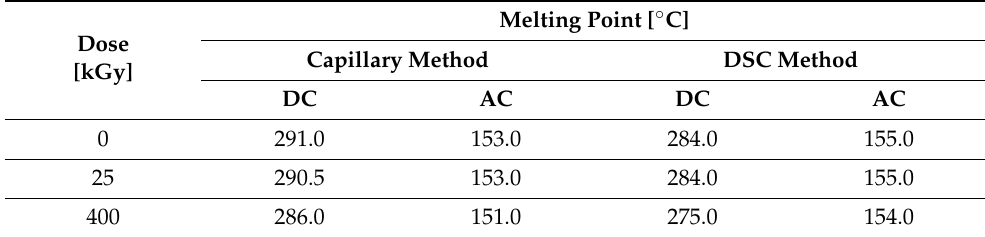
Table 1. Melting point results.